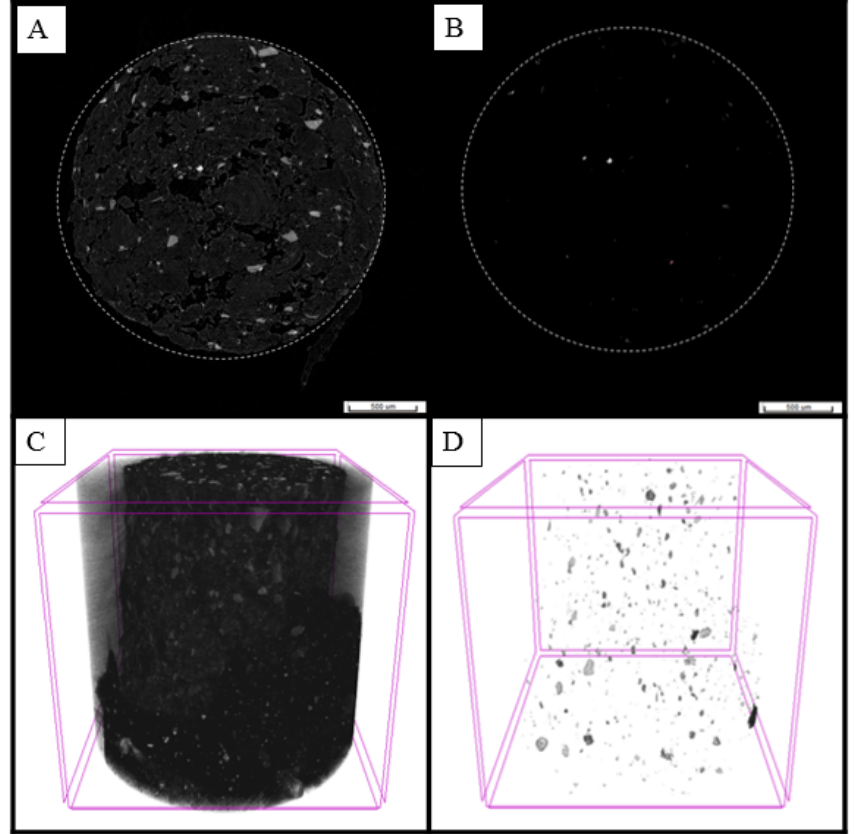
Figure 7. Micro-CT scan images of a pellet infused with barium-alginate microparticles. ( A ) 2D visualization; ( B ) 2D visualization of infused microparticles; ( C ) 3D visualization; ( D ) 3D visualization of infused microparticles. Measurement scale in the corner of images A and B indicates 500 μ m.